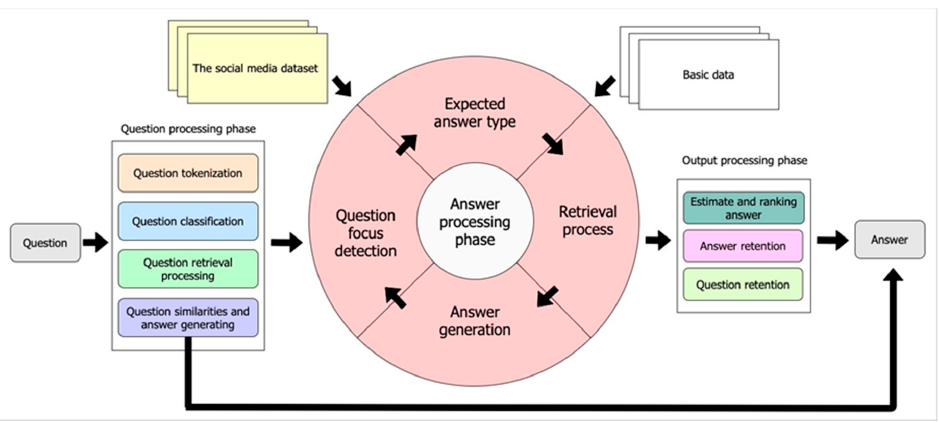
Figure 1. An overview framework of the integrated question answering system in natural disaster.